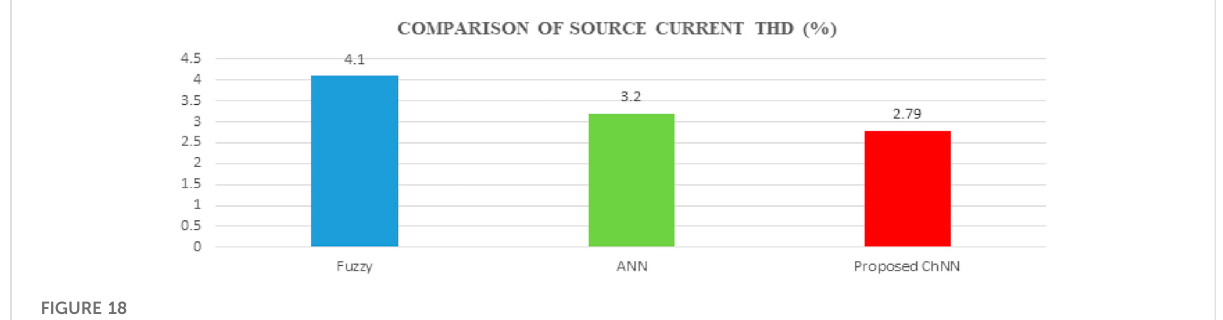
FIGURE 18 THD comparison.